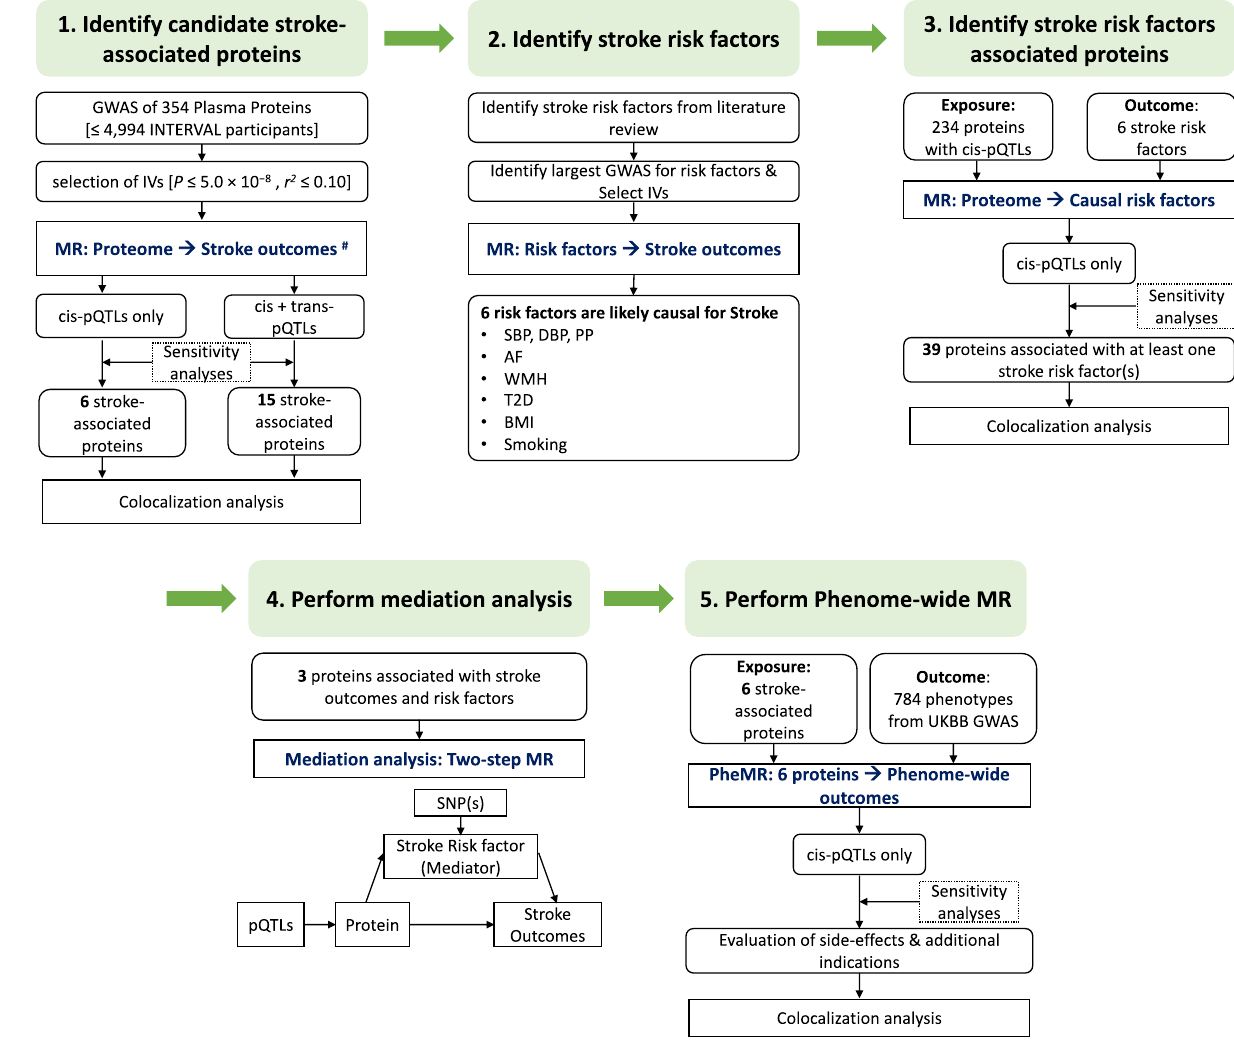
Fig. 1 | Overview of this MR study. Four O-link panels were used to measure plasma proteins in a subset of ~5000 samples from the INTERVAL study. Genetic variantsassociatedwithplasmaproteinlevelswereidenti fi edbasedonresultsfrom their corresponding GWAS. These genetic variants were then used as proxies for the protein level to test their relationship with stroke using data from the MEGA- STROKE consortium for stroke outcomes (Primary MR), and with conventional stroke risk factors that were causally associated with stroke (Secondary MR). Colocalization analyses were performed to test the shared genetic associations